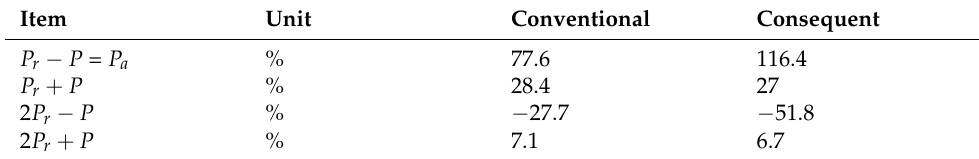
Table 4. Working harmonic